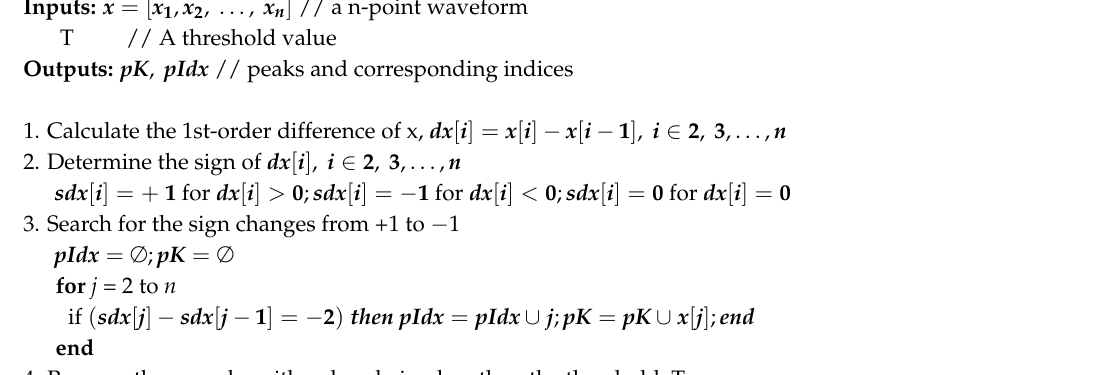
Algorithm 1. Pseudo-code of our peak detection algorithm.